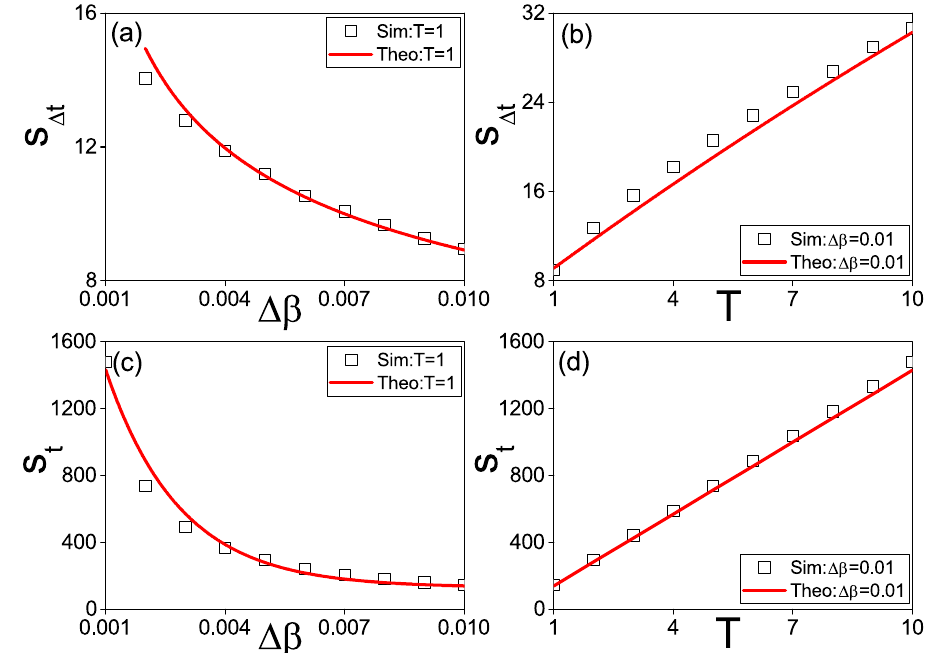
Figure 8. ( a ) and ( b ) represent the dependence of S Δ t on the two parameters Δ β and T in state space, respectively, where the “squares” denote the numerical simulations and the solid lines are the theoretical results from Eqs (11) and (16). ( c ) and ( d ) represent the corresponding S t of ( a ) and ( b ) in state space, respectively, where the “squares” denote the numerical simulations and the solid lines are the theoretical results from Eqs (11) and (16). The other parameters are the same as in Fig. 2(c) and